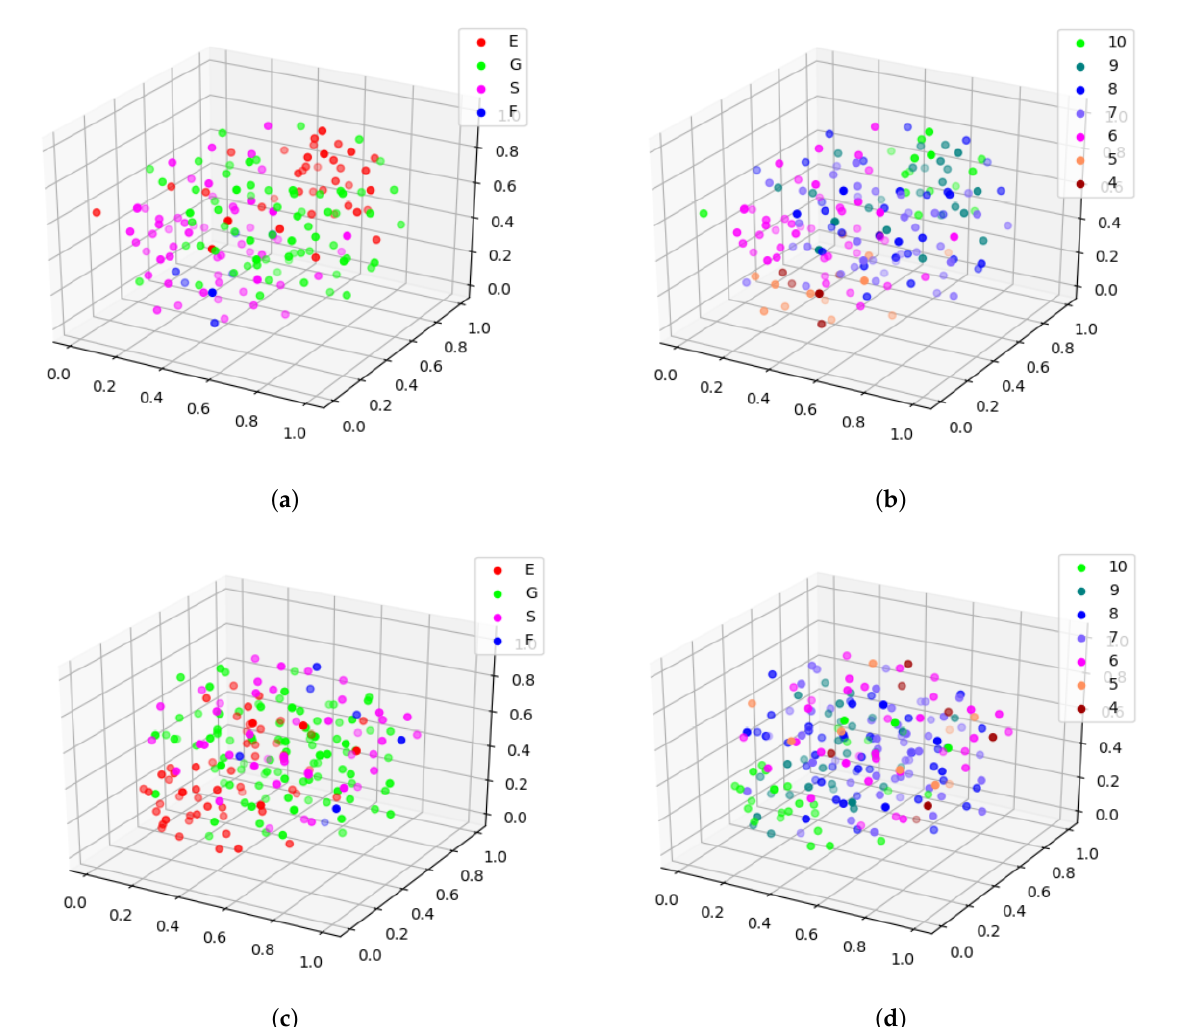
category ( a ) and grade -based classifications t and the